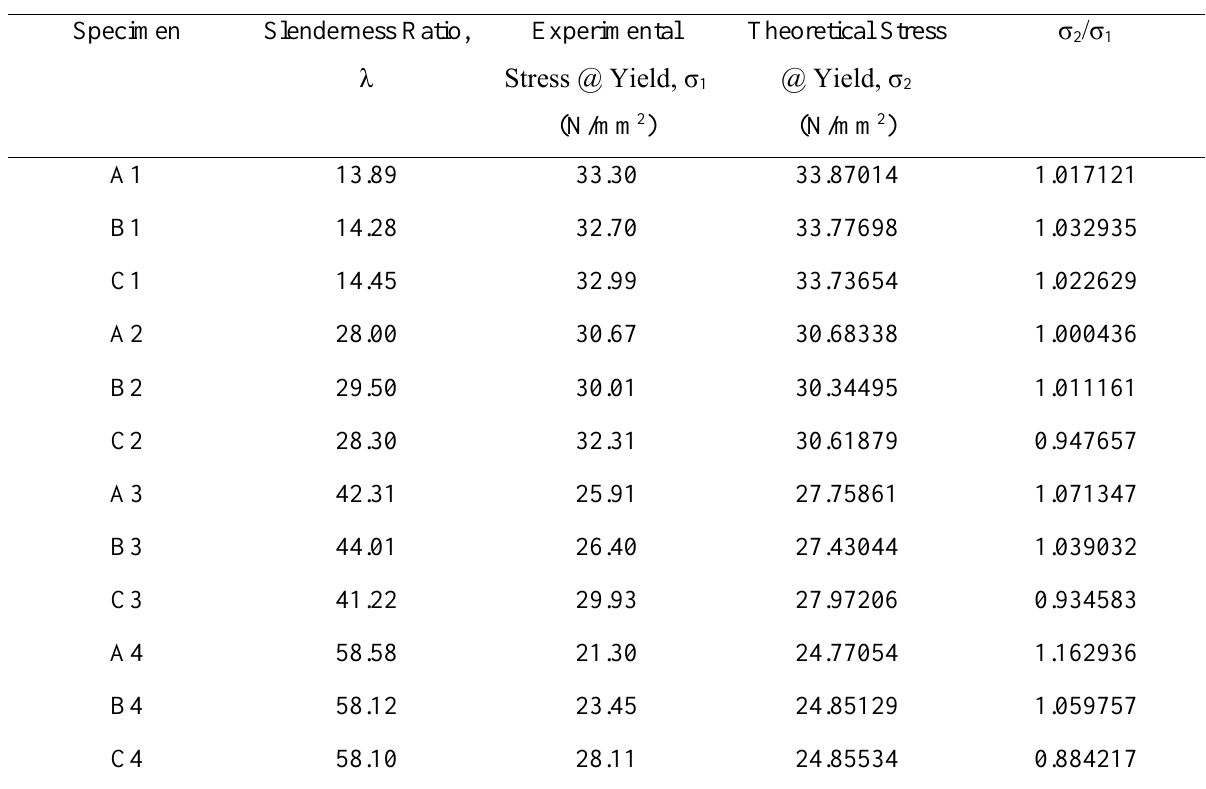
Theoretical Stress @ Yield and Slenderness Ratio for